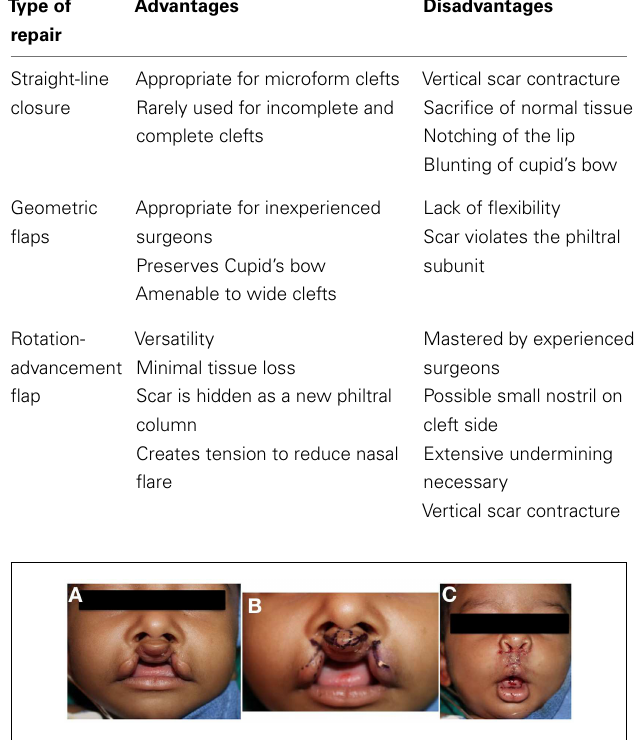
BILATERAL CLEFT LIP